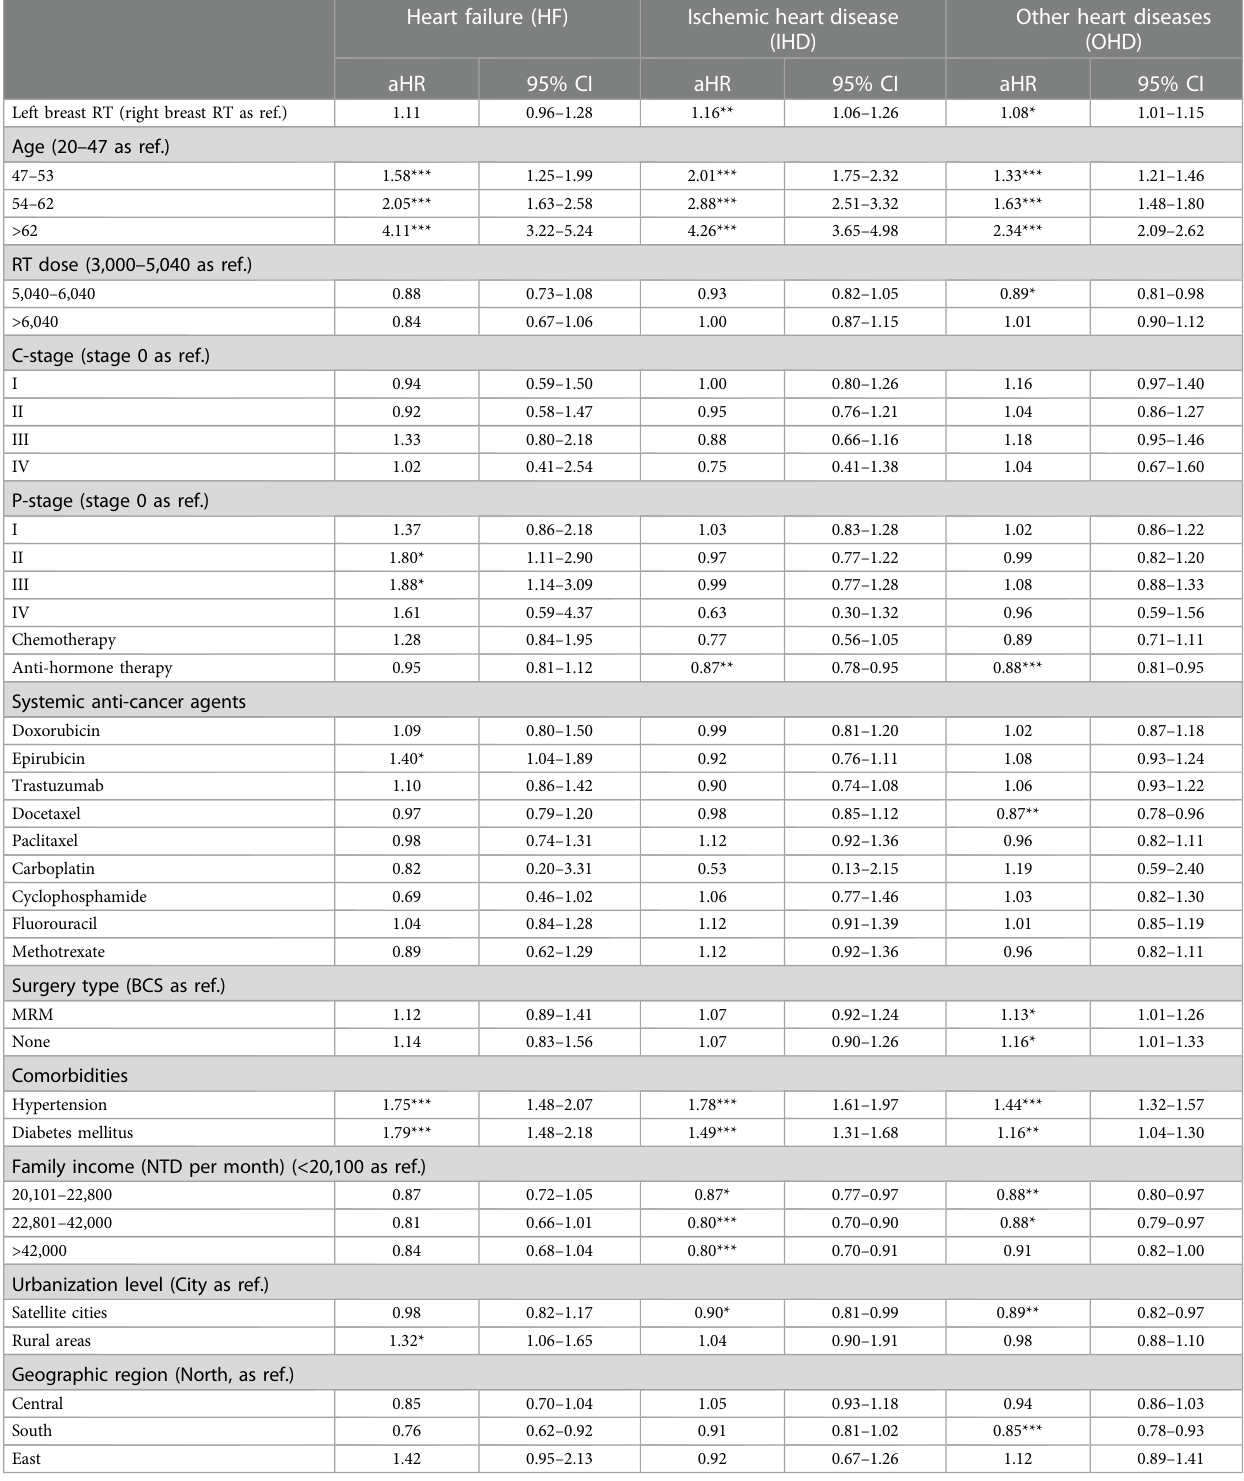
TABLE 2 Adjusted hazard ratios for heart diseases in breast cancer patients received